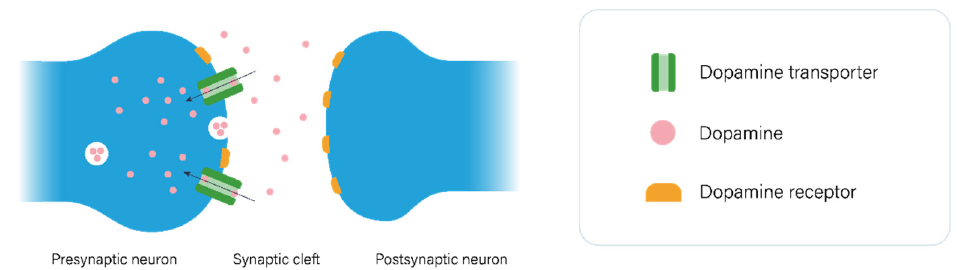
Figure 1. Visualization of dopaminergic neurotransmission in the synaptic cleft. Dopamine is released from the vesicles in the presynaptic neuron into the synaptic cleft, where it binds to either presynaptic or postsynaptic dopamine receptors or is transported back to the cytosol of the presynaptic neuron by dopamine transporters.